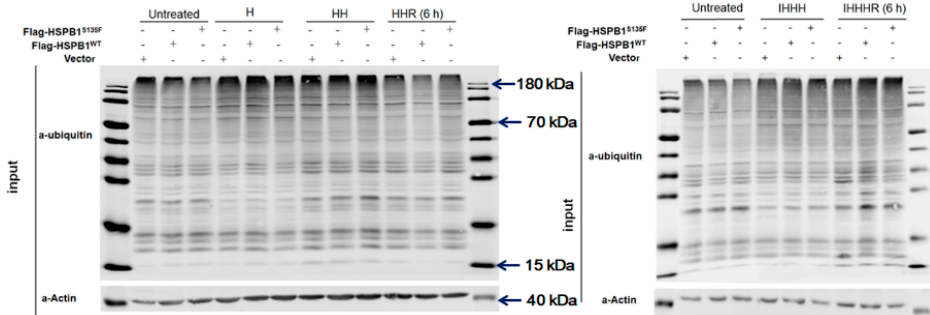
Figure 6. HSPB1 S135F prevents the clearance of ubiquitinated proteins in HEK293T cells.